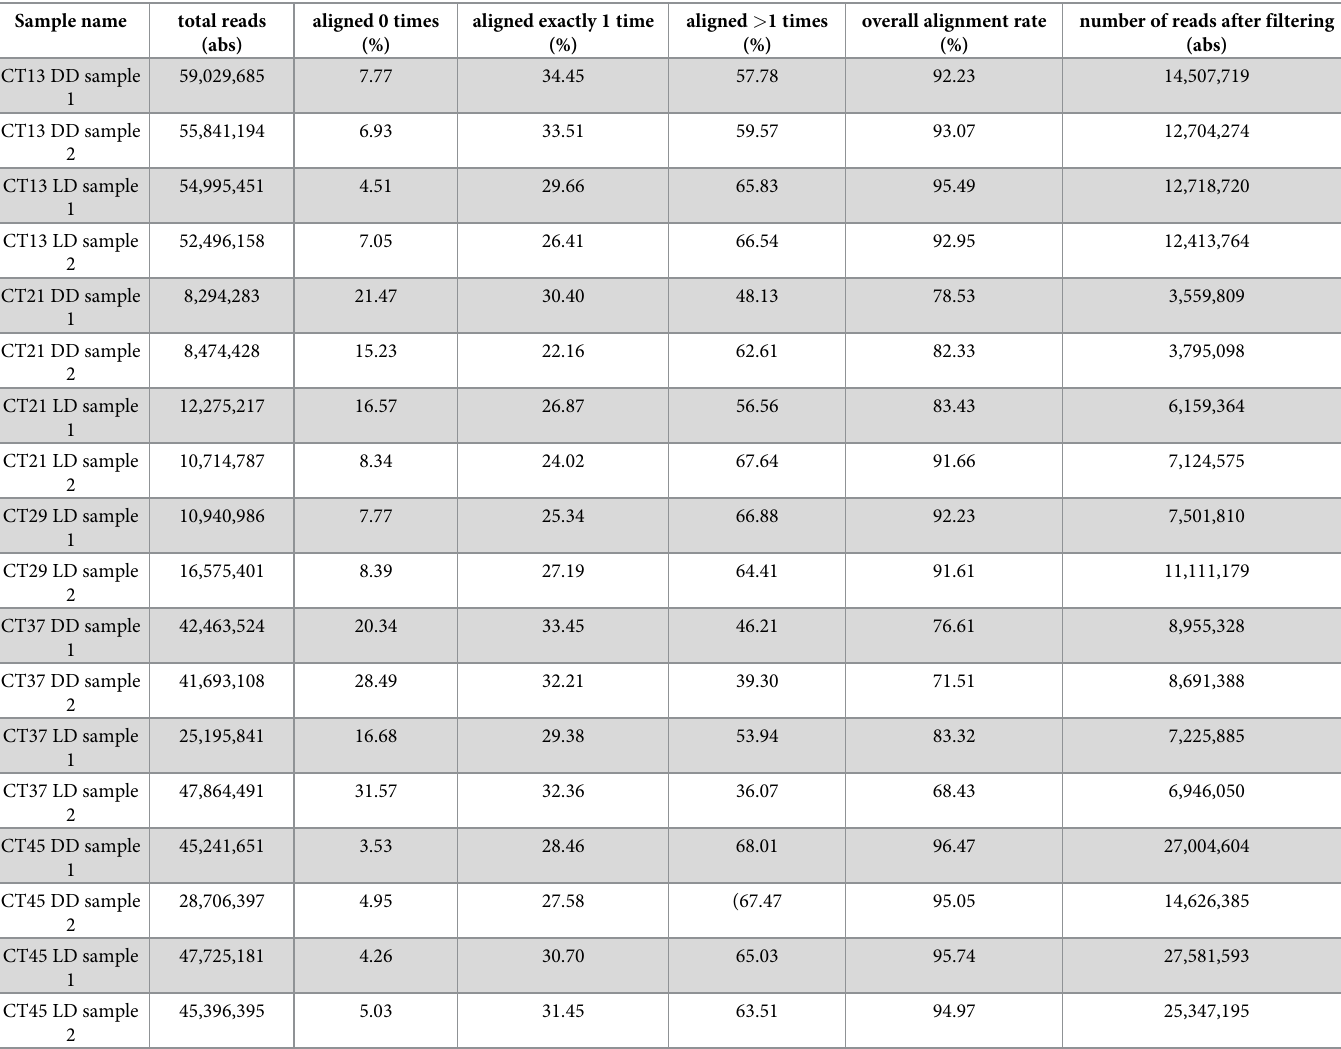
Table 1. Alignment rate to Nematostella vectensis genome (Genome version: